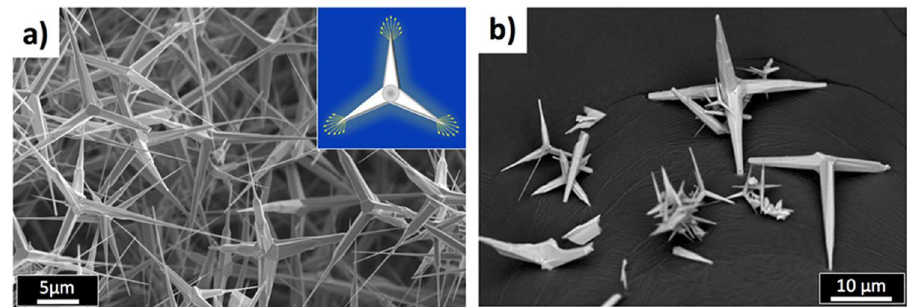
Figure 1. ( a ) SEM image of ZnO tetrapods grown by flame annealing. Inset: cartoon showing how the tips of the tetrapod can enhance the electric field for any given orientation of the field. ( b ) SEM image of the